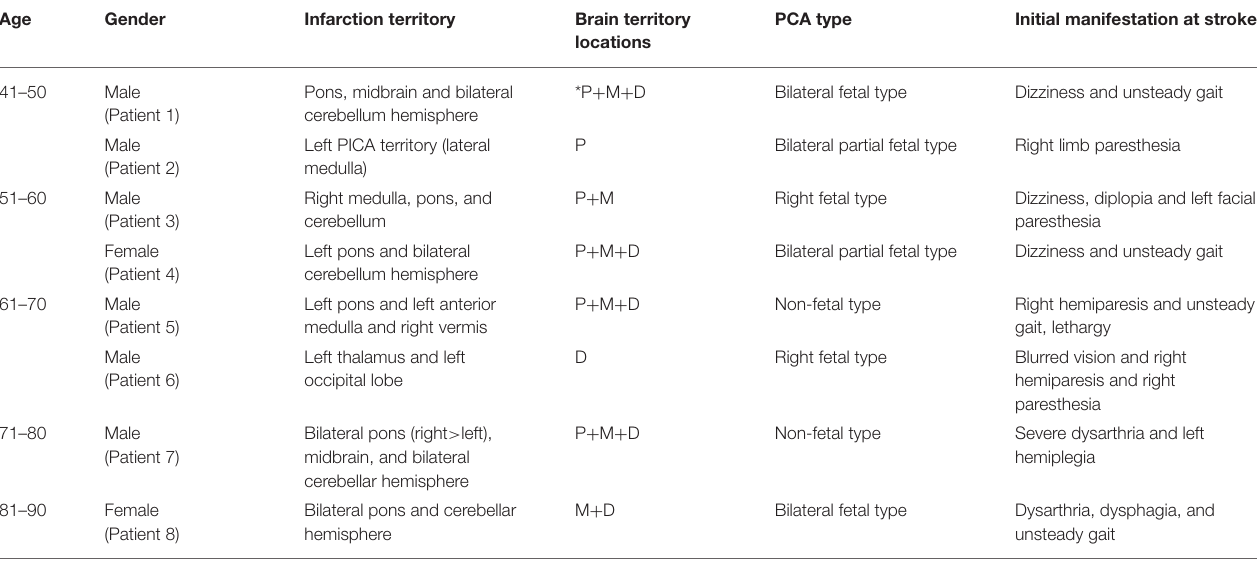
TABLE 3 | Infarction region and clinical manifestation of stroke in patient